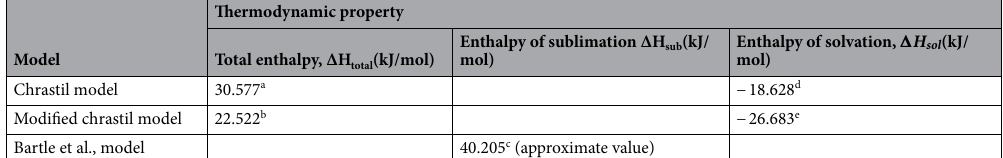
Table 5. Calculated thermodynamic properties for Crizotinibin solubility. d Obtained as a result of difference between the ΔH subc and ΔH totala . e Obtained as a result between the ΔH subc and ΔH totalb